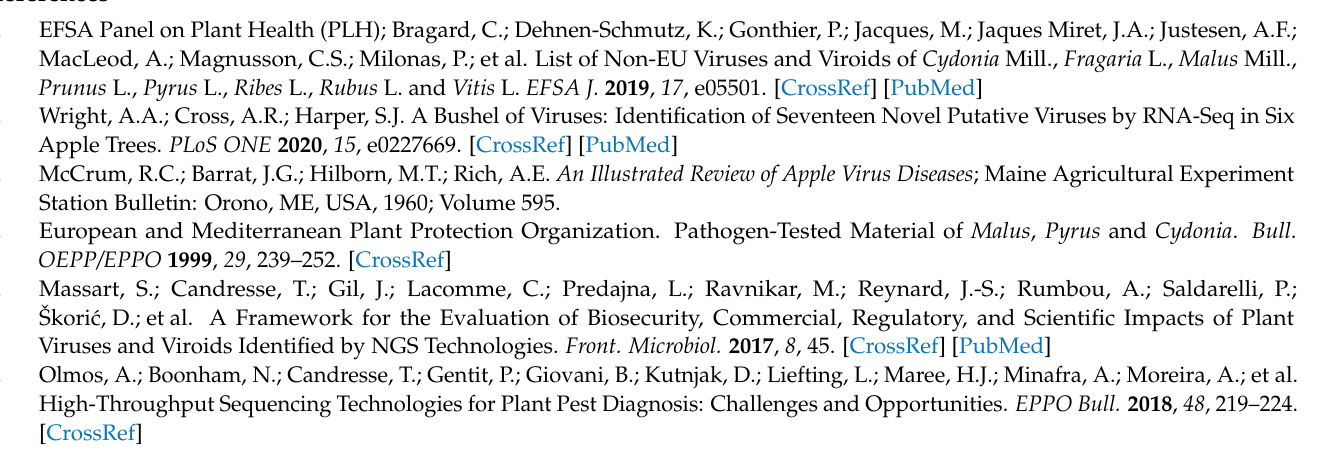
Asterisk (*) marks sample types: G—germplasm, P—private orchard, R—rootstock. AGCaV—apple green crinkle-associated virus, AHVd—apple hammerhead viroid, ALV-1—apple luteovirus 1, ACLSV—apple chlorotic leafspot virus, AMV—apple mosaic virus, ApLV—apricot latent virus, ARWV-1—apple rubbery wood virus 1, ARWV-2—apple rubbery wood virus 2, ASGV—apple stem grooving virus, CCGaV—citrus